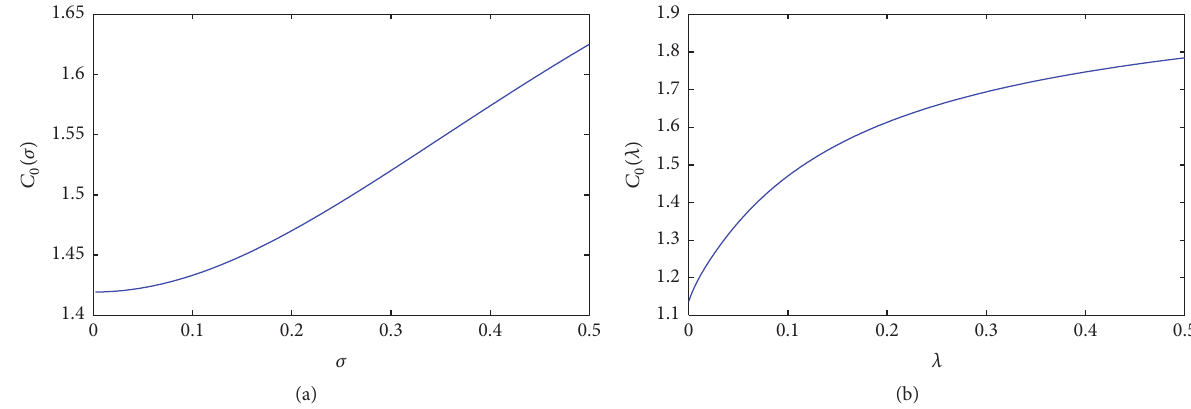
Figure 3: The relationship between the option price 𝐶 0 and market uncertainty 𝜎 (a) or major events uncertainty 𝜆 (b). Figure 3(a): 𝜆 = 0.1; 𝑟 = 0.04 ; 𝛿 = 0.02; 𝐼